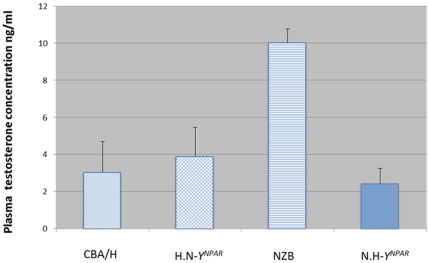
Plasma testosterone concentration (mean ±SEM) in NZB and CBA/H and their consomic strains for YNPAR.The N.H-YNPAR differs only from the NZB by the YNPAR from CBA/H, and the H.N-YNPAR differs only from the CBA/H by the YNPAR from NZB. Partial comparisons with Student's t test showed that the parental NZB and CBA/H strains differed significantly (P<0.0001), and the parental NZB strain differed significantly from its consomic strain (NZB vs. N.H-YNPAR: P<0.001); n = 10 animals for each strain; SEM = standard error of the mean.